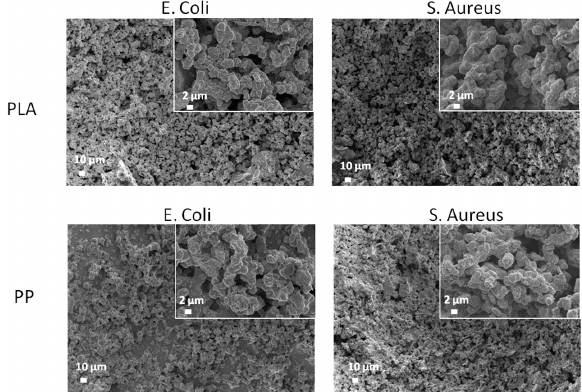
Figure 24. FESEM images of ZnO-coated PLA (top panels) and PP (bottom panels) samples after the antimicrobial assays performed by culturing E. coli (left panels) and S. aureus bacteria (right panels).